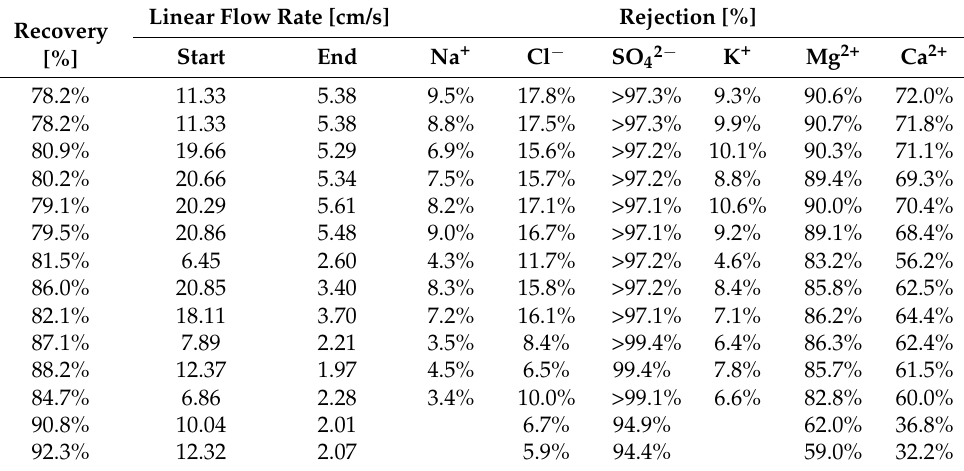
Table 1. Effect of permeate recovery and the linear flow rate in the feed/retentate channel at the beginning of 1st stage/end of 3rd stage on the ionic rejection coefficients observed during NF of “Budryk” coal mine water.